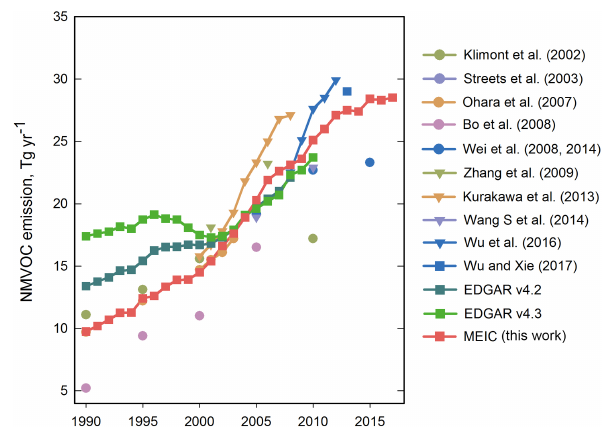
Figure 7. Comparisons of NMVOC emissions in China between this work and previous